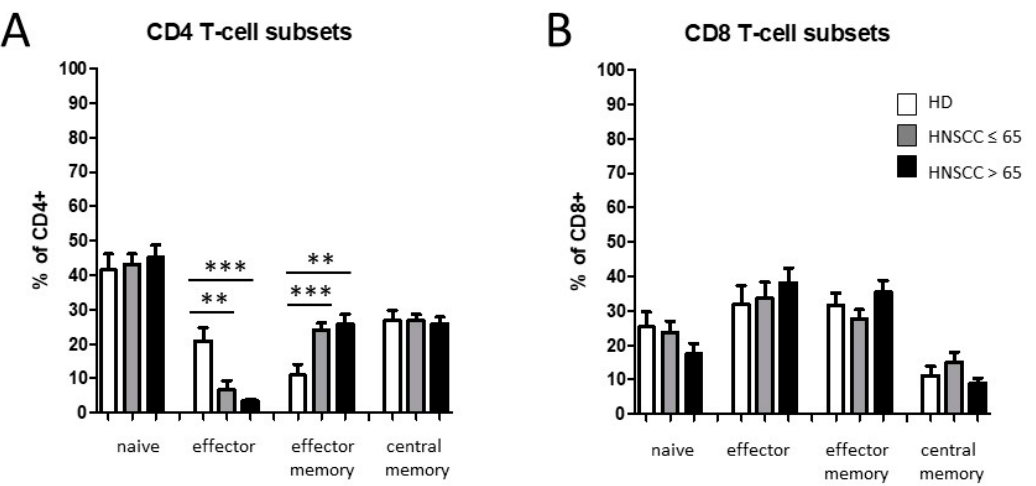
Figure 7. Flow cytometric analysis of CD4 + and CD8 + T cells in PBMC from healthy donors and HNSCC patients of two age-related cohorts ( ≤ 65 and > 65 years of age, respectively). ( A ) Percentages of naïve, effector, effector memory, and central memory T cells within CD4 + T cells. ( B ) Abundances of naïve, effector, effector memory, and central memory T cells within CD8 + T cells. ** p < 0.01; *** p < 0.001.